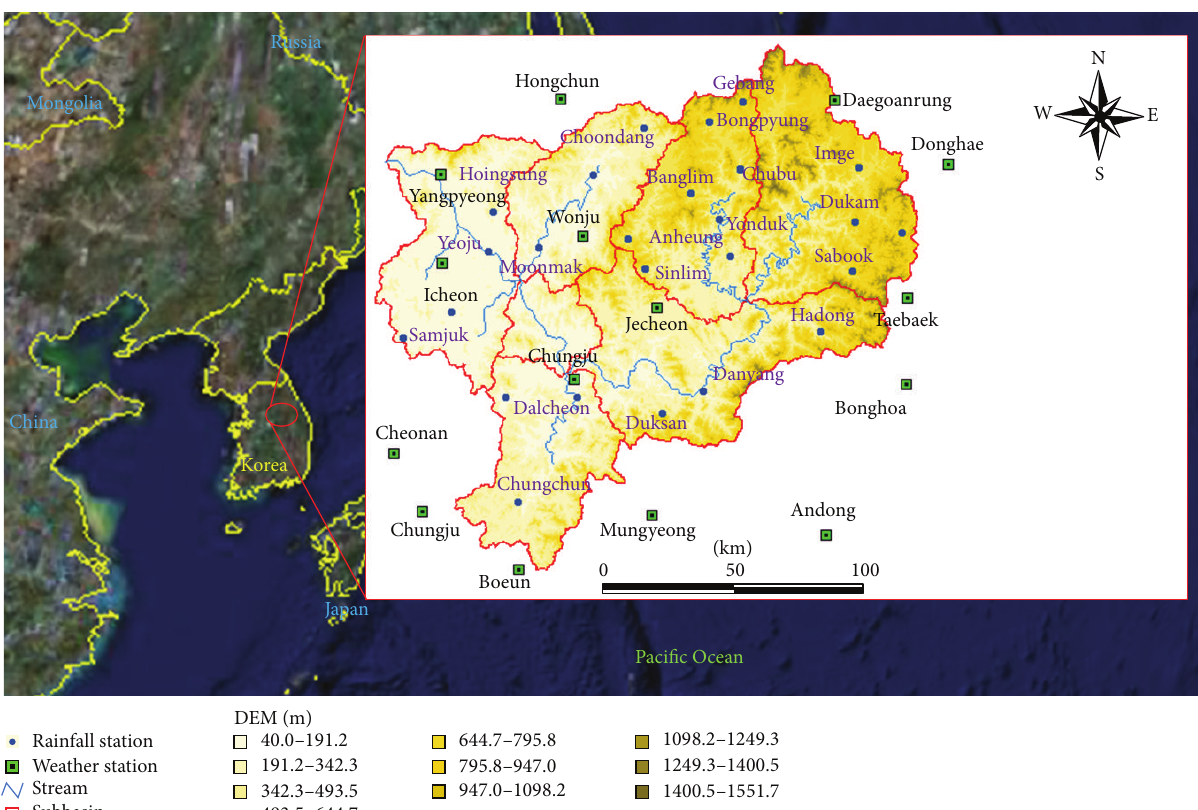
Figure 1: Study area and the location of weather and rainfall